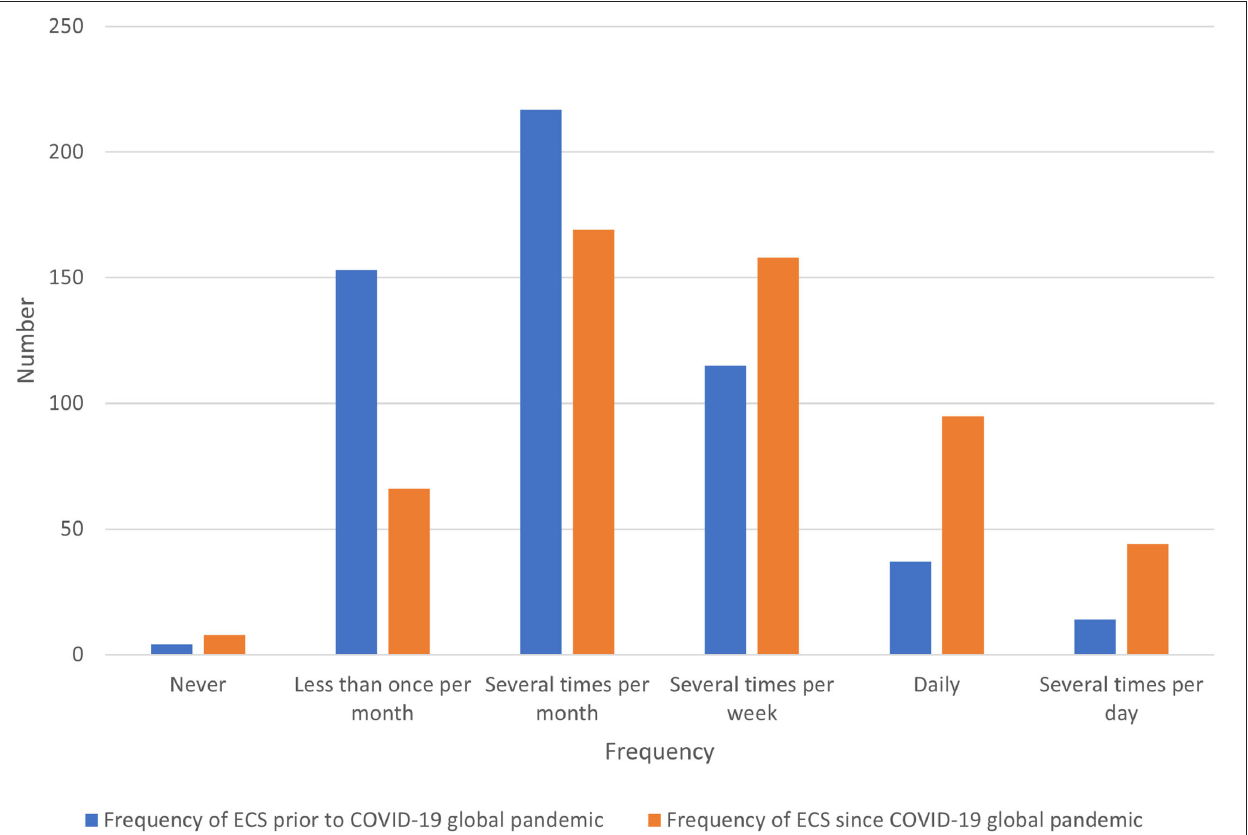
FIGURE 1 | Bar chart for the median frequency of ethically challenging situations (ECS) encountered by veterinary teams prior to and since the advent of the COVID-19 global pandemic, based on the responses of 540 veterinarians, animal health technicians and veterinary nurses, surveyed between May and July in